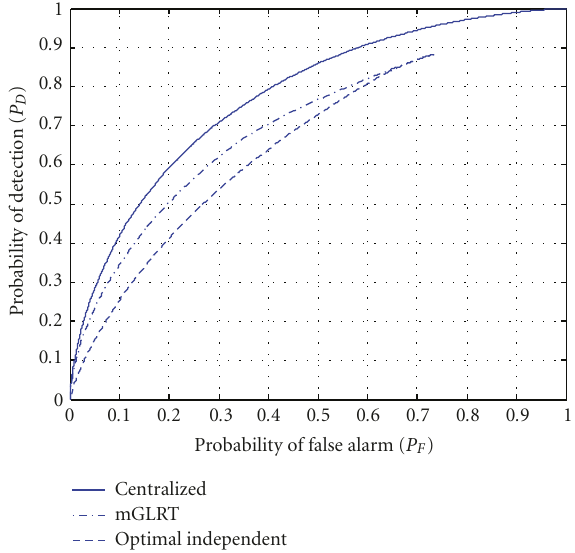
Figure 6: ROC curve of the mGLRT, and optimal independent test = 5, σ 2 = 4 for sensors in the for the eight-sensor example with σ 2 ii ij = 2 for sensors in di ff erent sets. The communication same set, σ 2 ij rate constraint for each sensor is κ i =